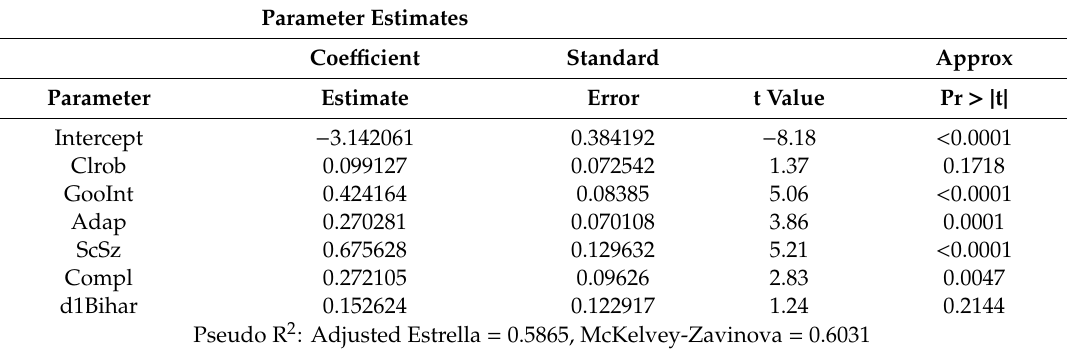
Table 11. Ordered probit regression results—institutional features and overall